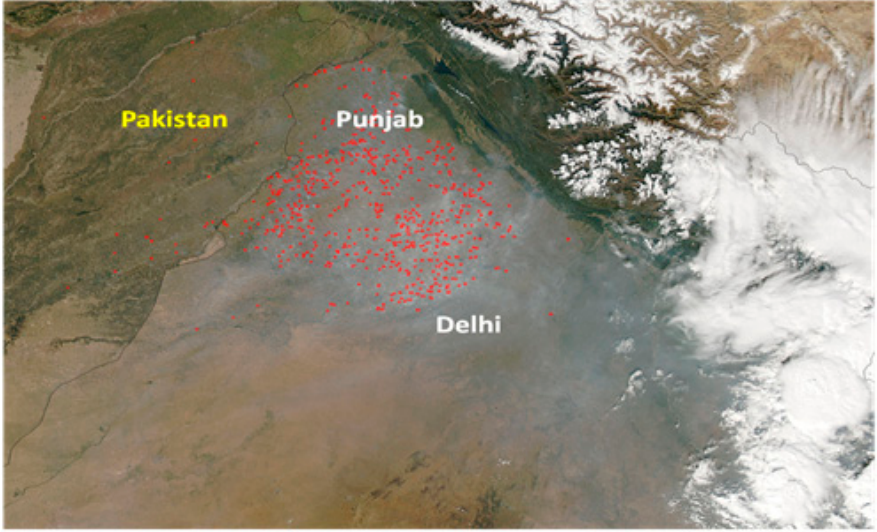
Figure 2. Crop burning areas in Punjab and Haryana, as captured by NASA [65].